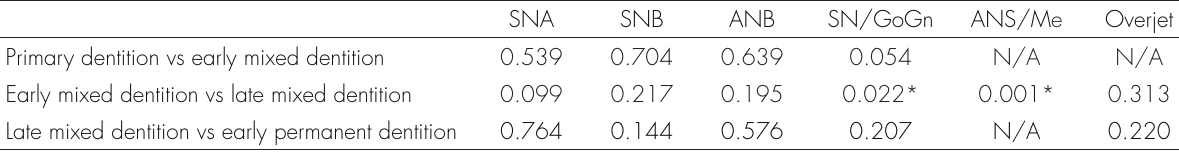
Table IV. Egger’s test for the analysis of small study effects on publication bias.